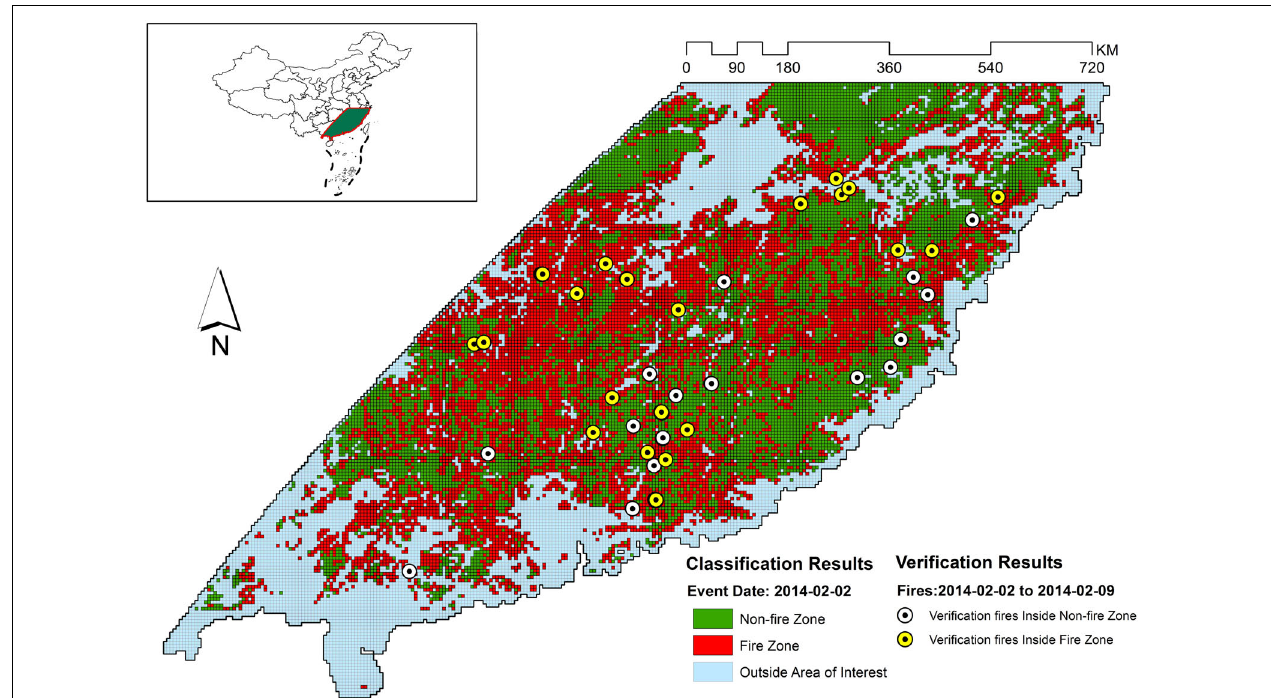
FIGURE 9 | Classification and verification results for 2014-02-02.